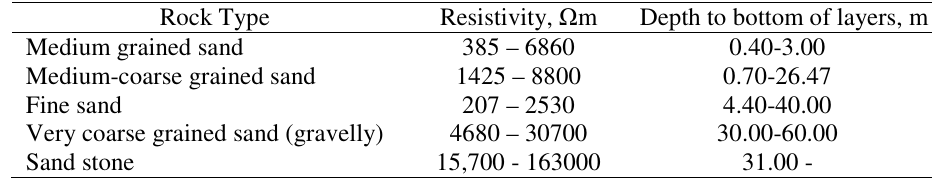
Figure 2. A typical curve (AKHA, KHA and HKHA curve, type) from VES 18 of the study area. Table 2. Inferred rock matrixes and their corresponding ranges of ressistivity and depthsobtained by correlations of VES and the nearby logged boreholes in the study